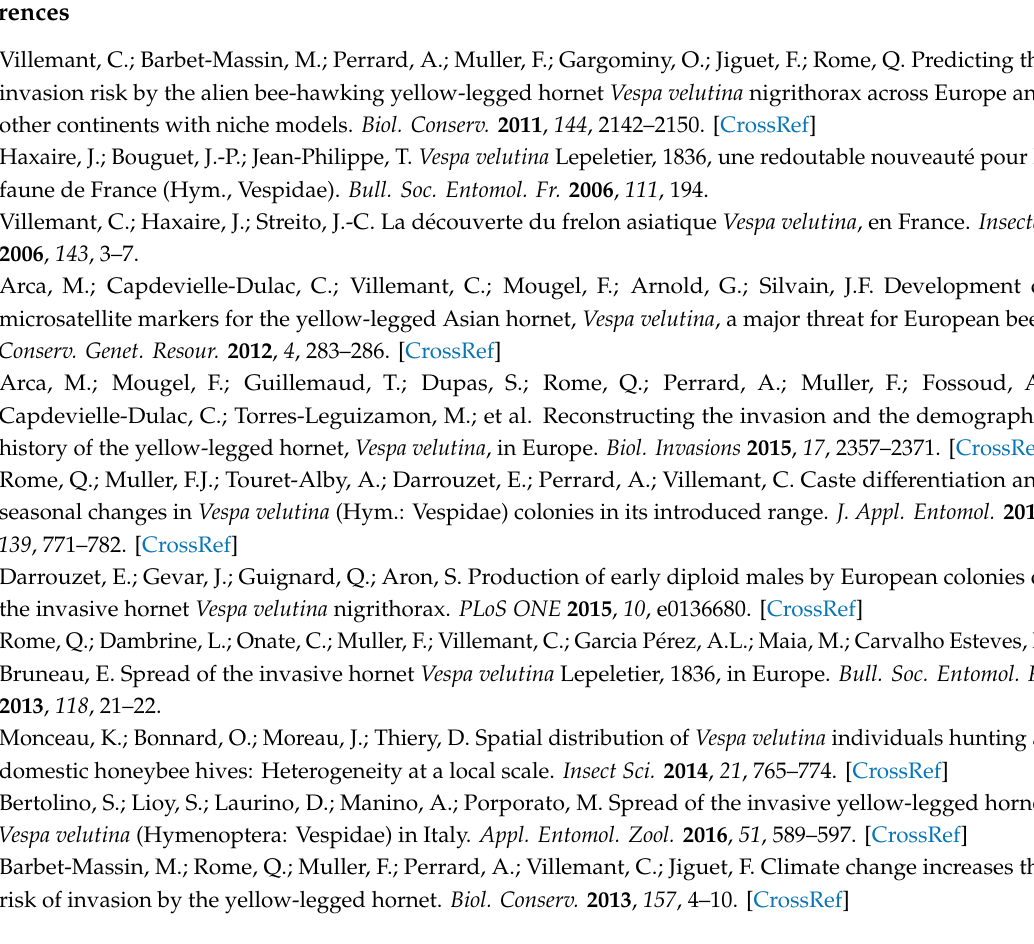
Table S1: Hornet and honey bee sample list and corresponding viral PCR detections. Table S2: Accessions number and virus names of sequences used in virus phylogenies. Table S3: Polymorphism and expression levels of viral sequences between samples. Table S4: Read counts (and read %) supporting SNP from Vespa velutina-associated acypi-like virus across hornet samples. Figure S1: Kraken counts from reduced fasta contigs for brain (140C), muscle (140M, 159M) or gut (144I) samples. Only the most significant values and honey bee-associated viruses are shown. Figure S2: Quality plots of RNAseq reads of Vespa velutina samples 140C and 140M before FastQC trimming. Figure S3: Quality plots of RNAseq reads of Vespa velutina samples 144I and 159M before FastQC trimming. Figure S4: Schematic representation, coverage and annotation of complete Deformed wing virus genome found in hornets. (a–d): Deformed wing virus strain B found in 140C, 140M, 144I, and 159M, respectively. Figure S5: Multiplex PCR virus detection for six hornet and four bee samples originating from each apiary (Table S1). Ladder 100 bp is from Promega, the most intense band corresponds to a 500-bp sized fragment. Figure S6: Schematic representation, coverage and annotation of complete or partial genomes of RNA honey bee-associated viruses found in hornets. (a) Aphid lethal paralysis virus -like, (b) Bee macula-like virus, (c) Moku virus, (d) Kashmir bee virus , (e) Acute bee paralysis virus and (f) Black queen cell virus . Figure S7: Maximum likelihood amino acid phylogeny of Bee macula-like virus replicase from hornets (243 aa, LG + I + G + F model). GenBank accessions are shown in Table S2. Figure S8: Maximum likelihood amino acid replicase phylogeny of (a) Acute bee paralysis virus (139 amino acids, JTT + G model) and (b) Black queen cell virus (8,683 aa, GTR + G + I model). GenBank accessions are shown in Table